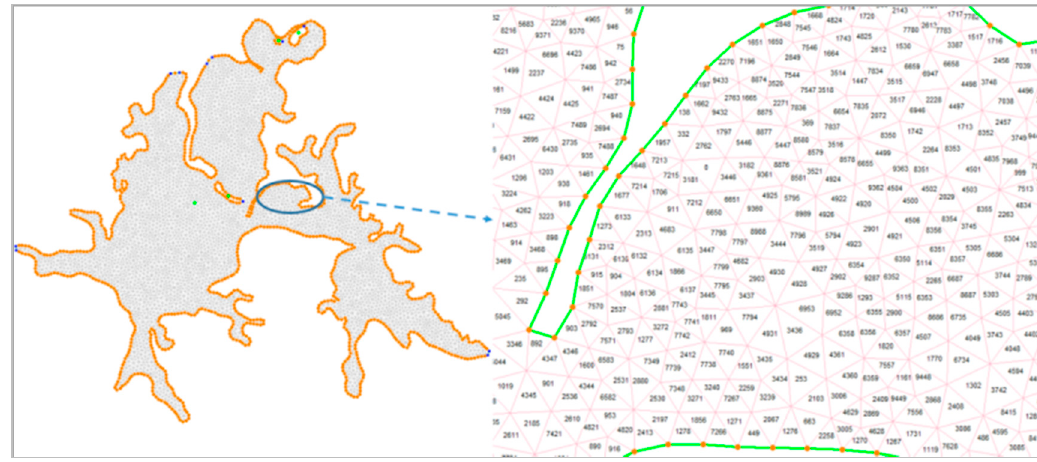
Figure 6. Results of Donghu Lake unstructured triangular meshes.